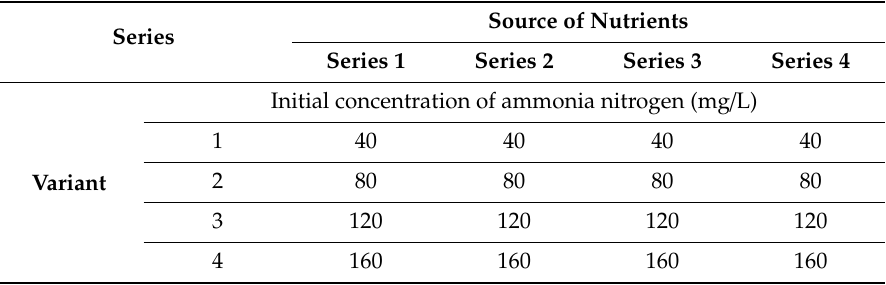
Table 1. Organization of the experiment.